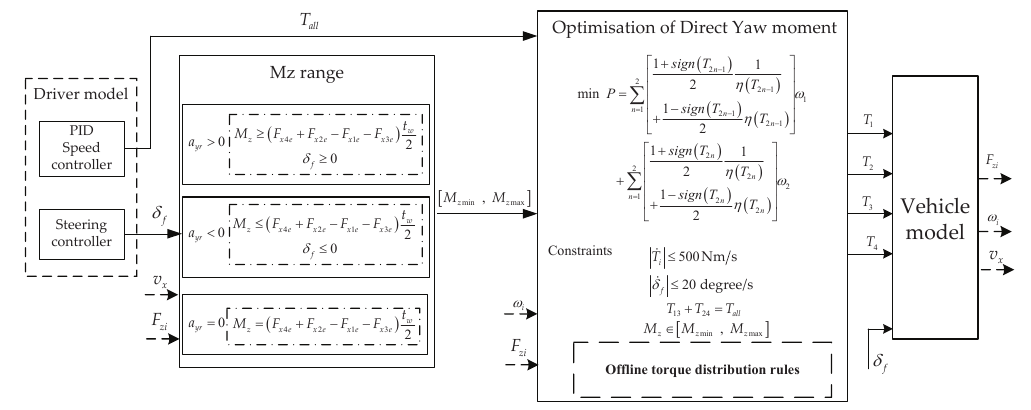
Figure 10. The structure of the